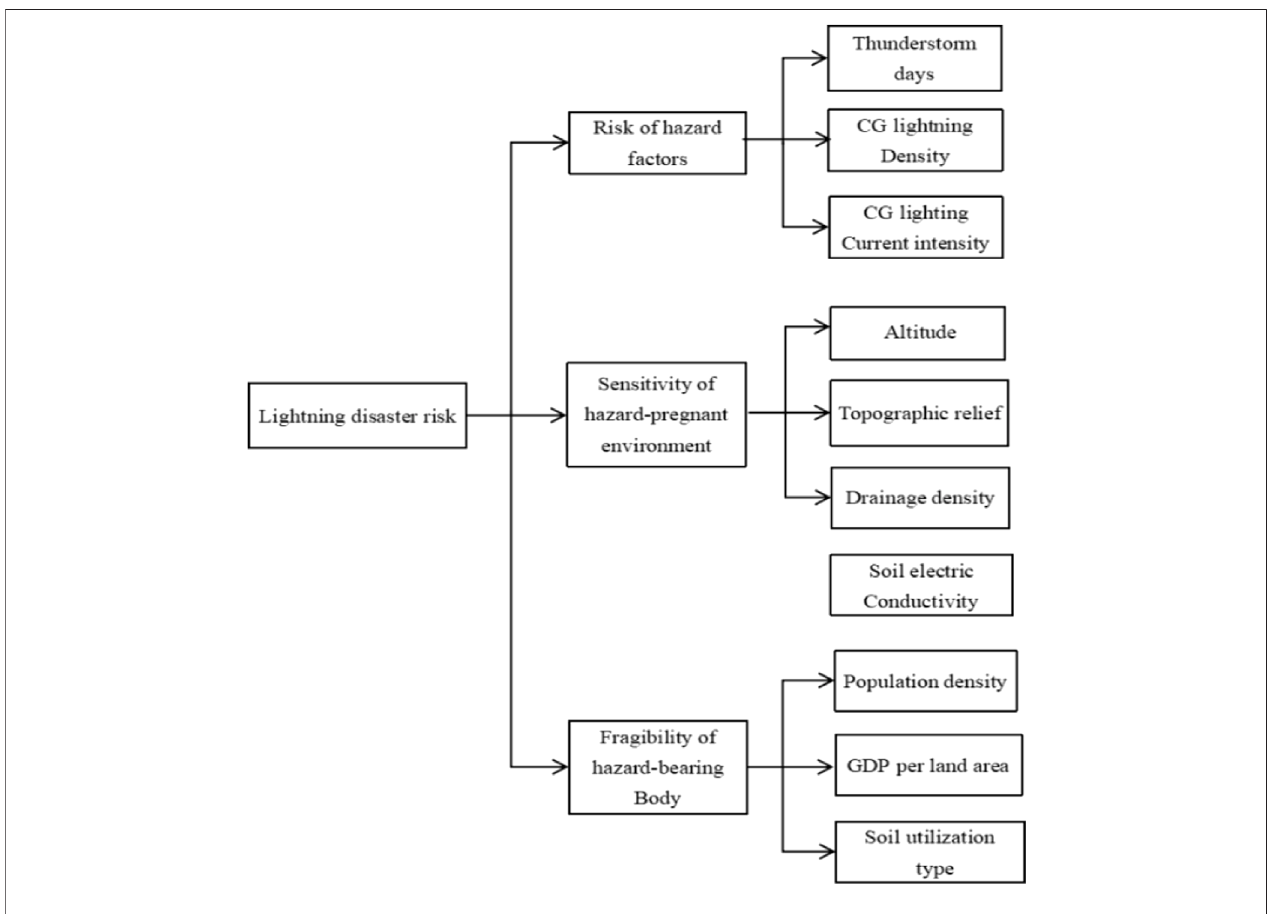
FIGURE 2 | Lightning disaster risk evaluation index